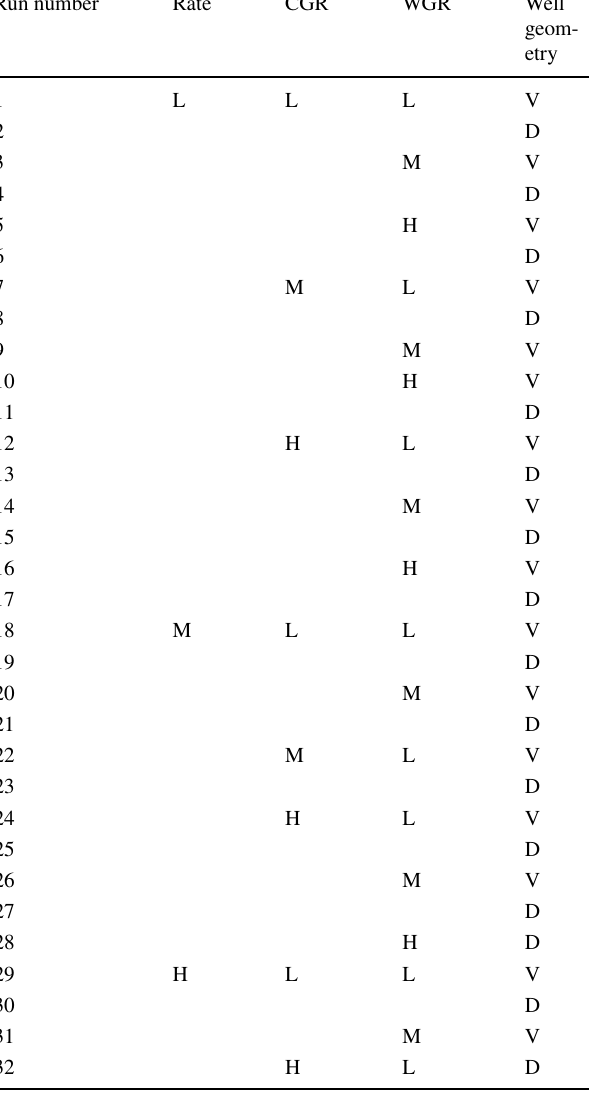
Table 3 Classification of different model runs